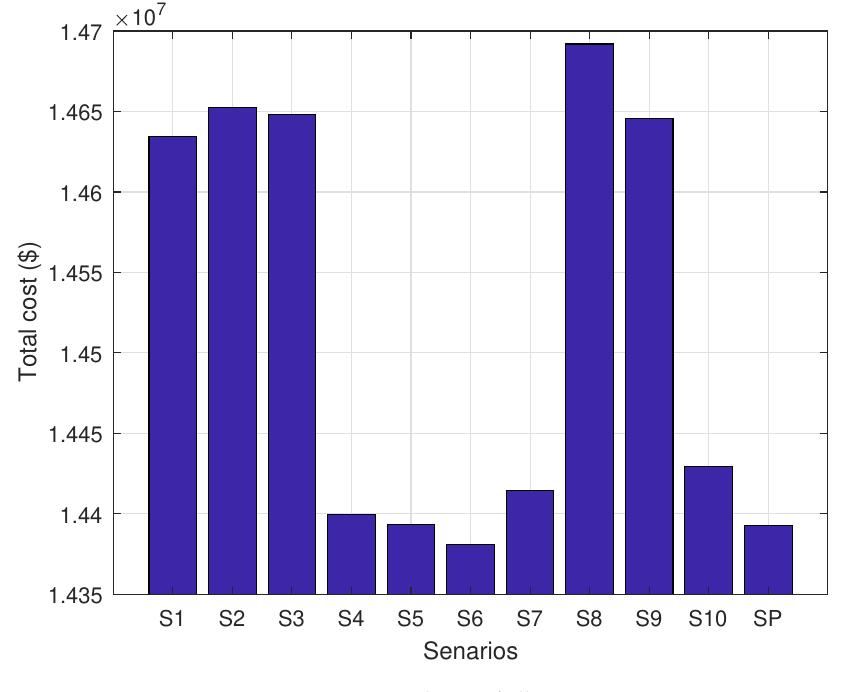
Figure 16. Total cost of all scenarios.